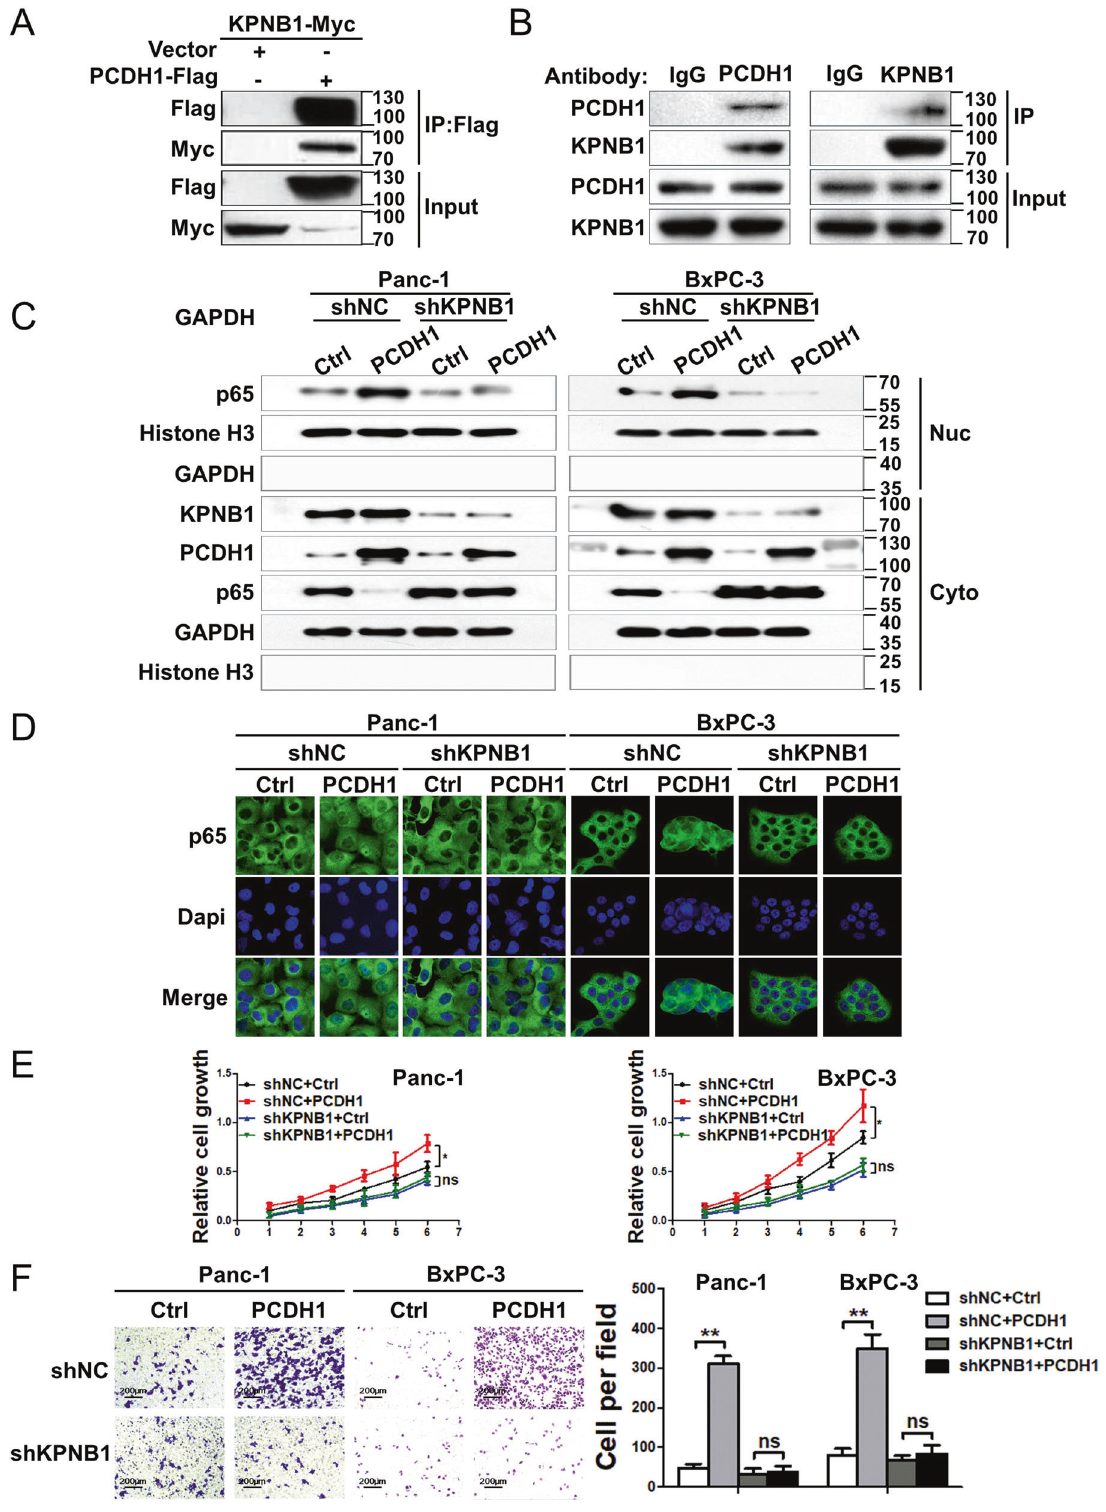
Fig. 6 PCDH1 activates the NF- κ B pathway during PDAC progression by interacting with KPNB1. A Coimmunoprecipitation (co-IP) and Western blot assays showing exogenous PCDH1 and KPNB1 expression in Panc-1 cells. B Co-IP and Western blot assays showing endogenous PCDH1 and KPNB1 expression in Panc-1 cells. Western blot assay ( C ) and immuno fl uorescence assays (D) were performed to detect the effect of PCDH1 on the nuclear localization of p65 after KPNB1 silencing. MTT ( D ) and Transwell assays ( E ) were performed to detect the effects of PCDH1 expression on PDAC cell proliferation and migration after KPNB1 silencing. The results presented are the mean ± SD of three independent experiments. The data were assessed by Student ’ s 2-tailed t test. * P < 0.05, ** P < 0.01.